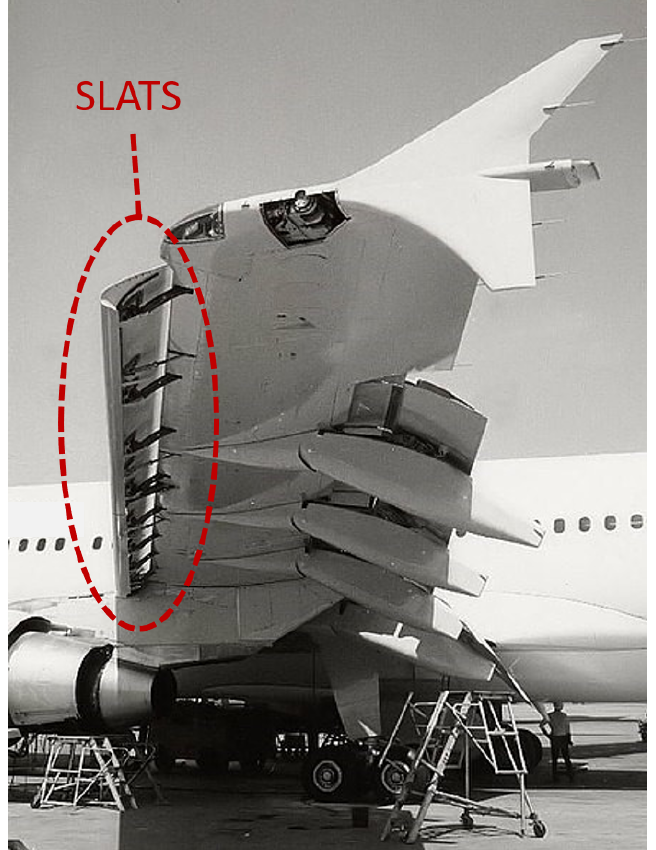
Figure 1. Wing with